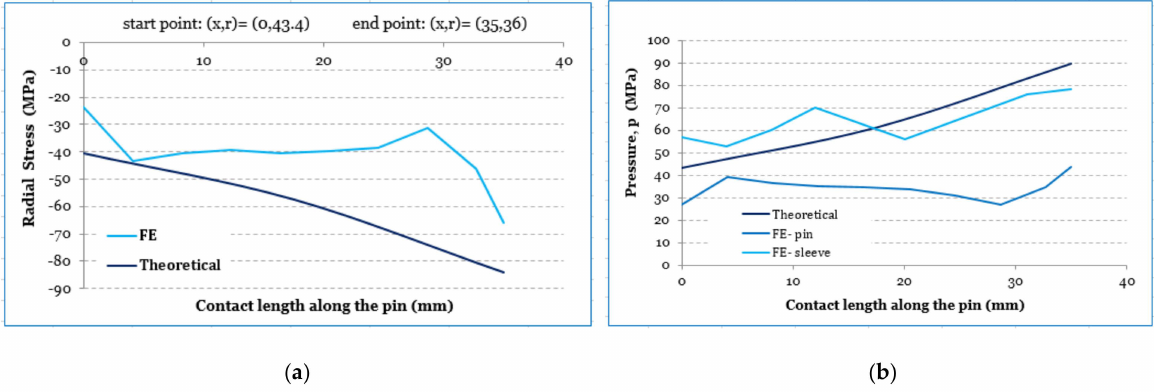
Figure 11. Stresses in pin along contact length. ( a ) Comparison of pin radial stress ( b ) Comparison of contact